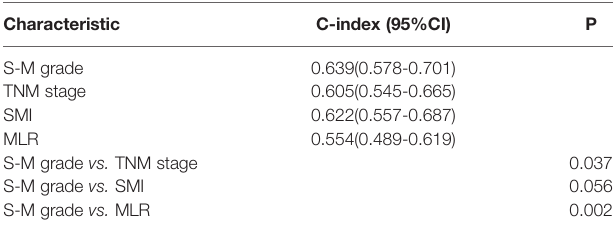
TABLE 2 | The C-index of S-M grade, TNM stage, SMI, and MLR for prediction of overall survival.